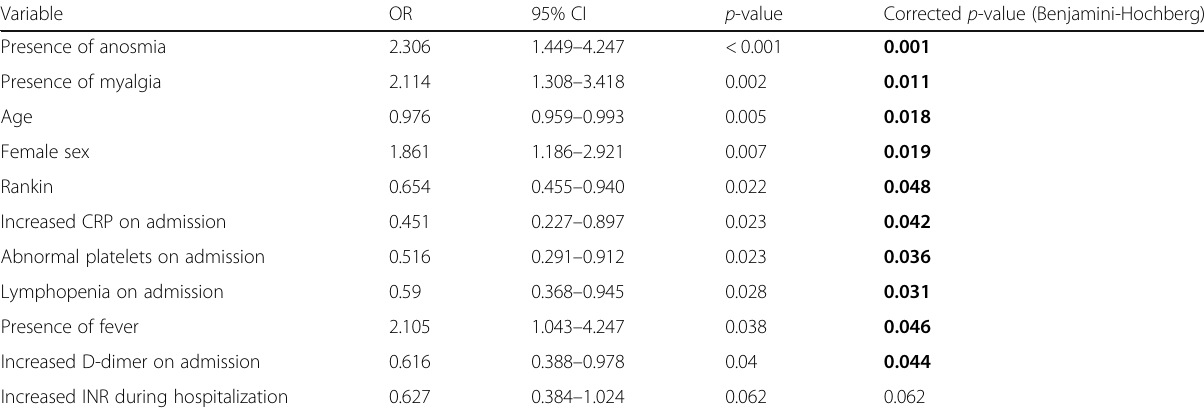
Table 5 Multivariate regression analysis of variables that were associated with the presence of headache